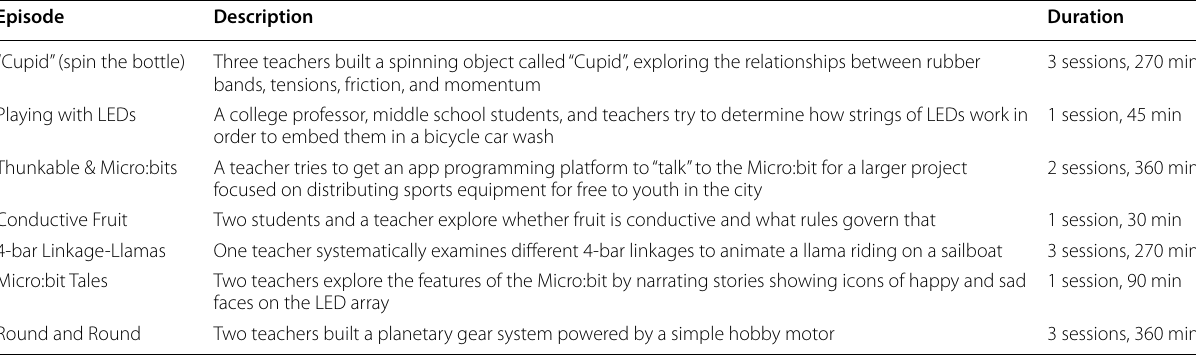
Table 1 Identified episodes of teachers and students engaging in computational play Episode